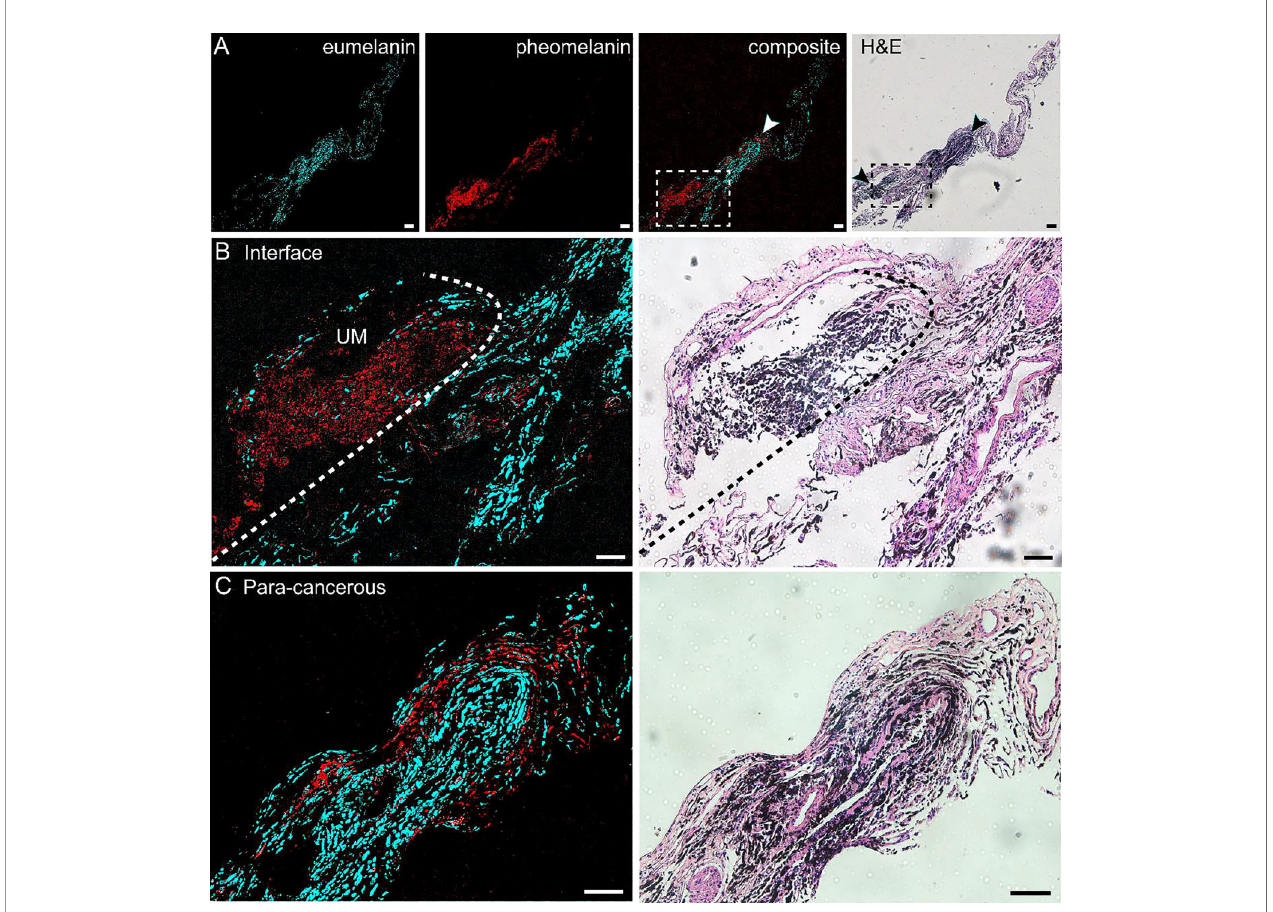
FIGURE 2 | Differentiation of melanoma and paracancerous regions with pump-probe microscopy on frozen tissue sections. (A) Pump-probe images and corresponding H&E staining of a whole tissue section. (B) Magni fi ed images in panel (A) (dashed rectangle) with the melanoma/paracancer interface de fi ned by melanin species distribution, which agrees with the histological interface found in the adjacent H&E section. (C) Magni fi ed paracancerous region [arrowhead in panel (A) ] demonstrated predominantly pheomelanin. Red: eumelanin; cyan: pheomelanin. Scale bar: 50 m